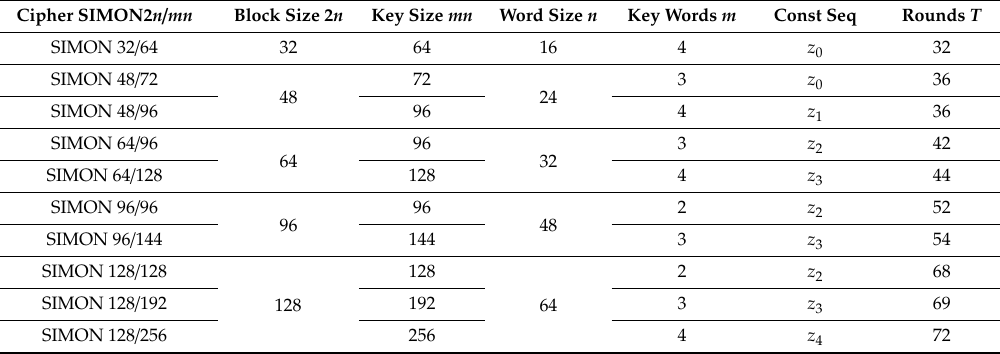
Table 1. Parameters of the SIMON